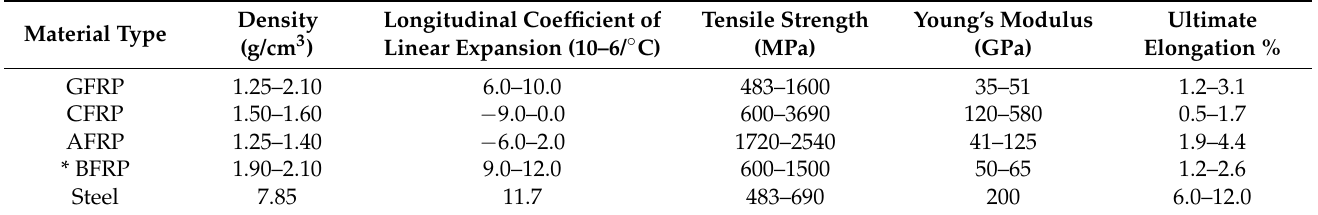
Table 1. Comparison of basic physical and mechanical properties between FRP materials and steel